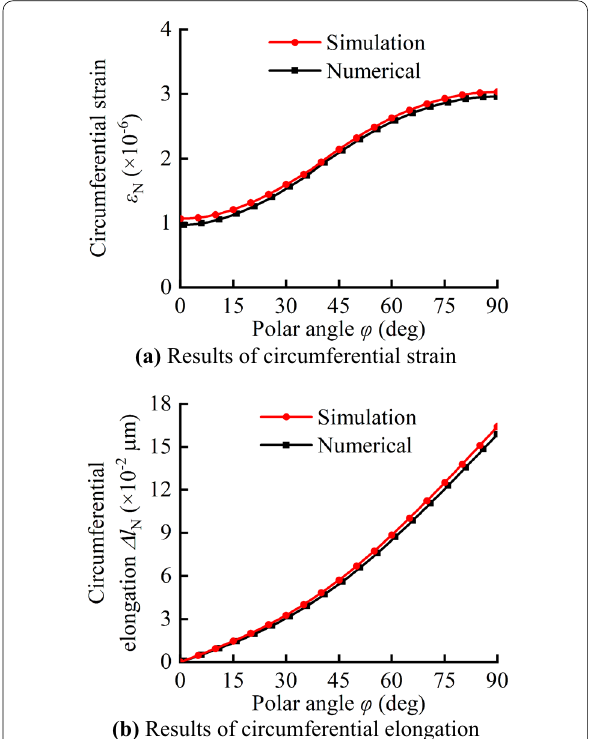
Figure 8 Circumferential strain and elongation of the ring under the elliptical